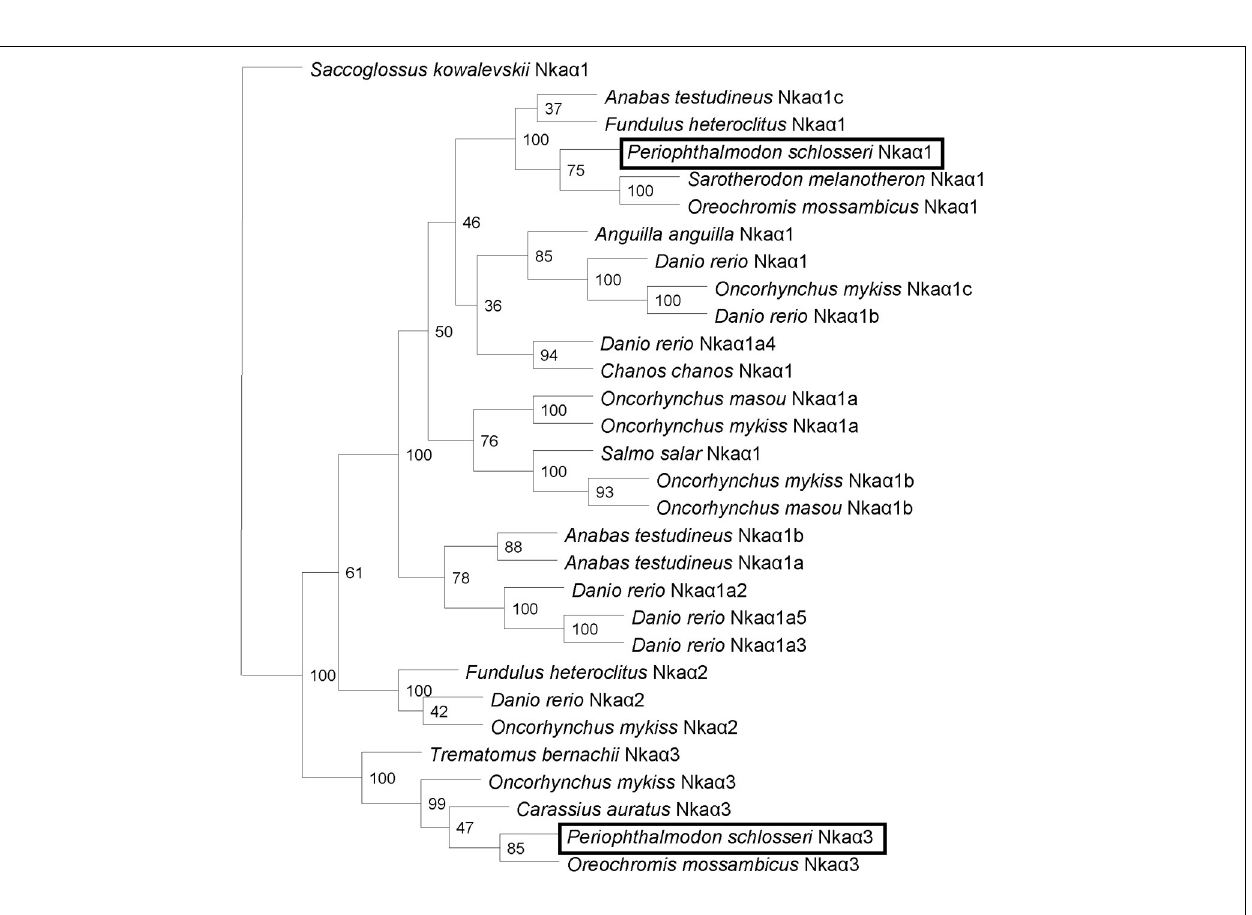
FIGURE 5 | Phenogramic analysis of Na + /K + -ATPase (Nka) α 1 and Nka α 3. A phenogram generated through phylogenetic analysis to illustrate the relationship between Nka α 1 and Nka α 3 from gills of Periophthalmodon